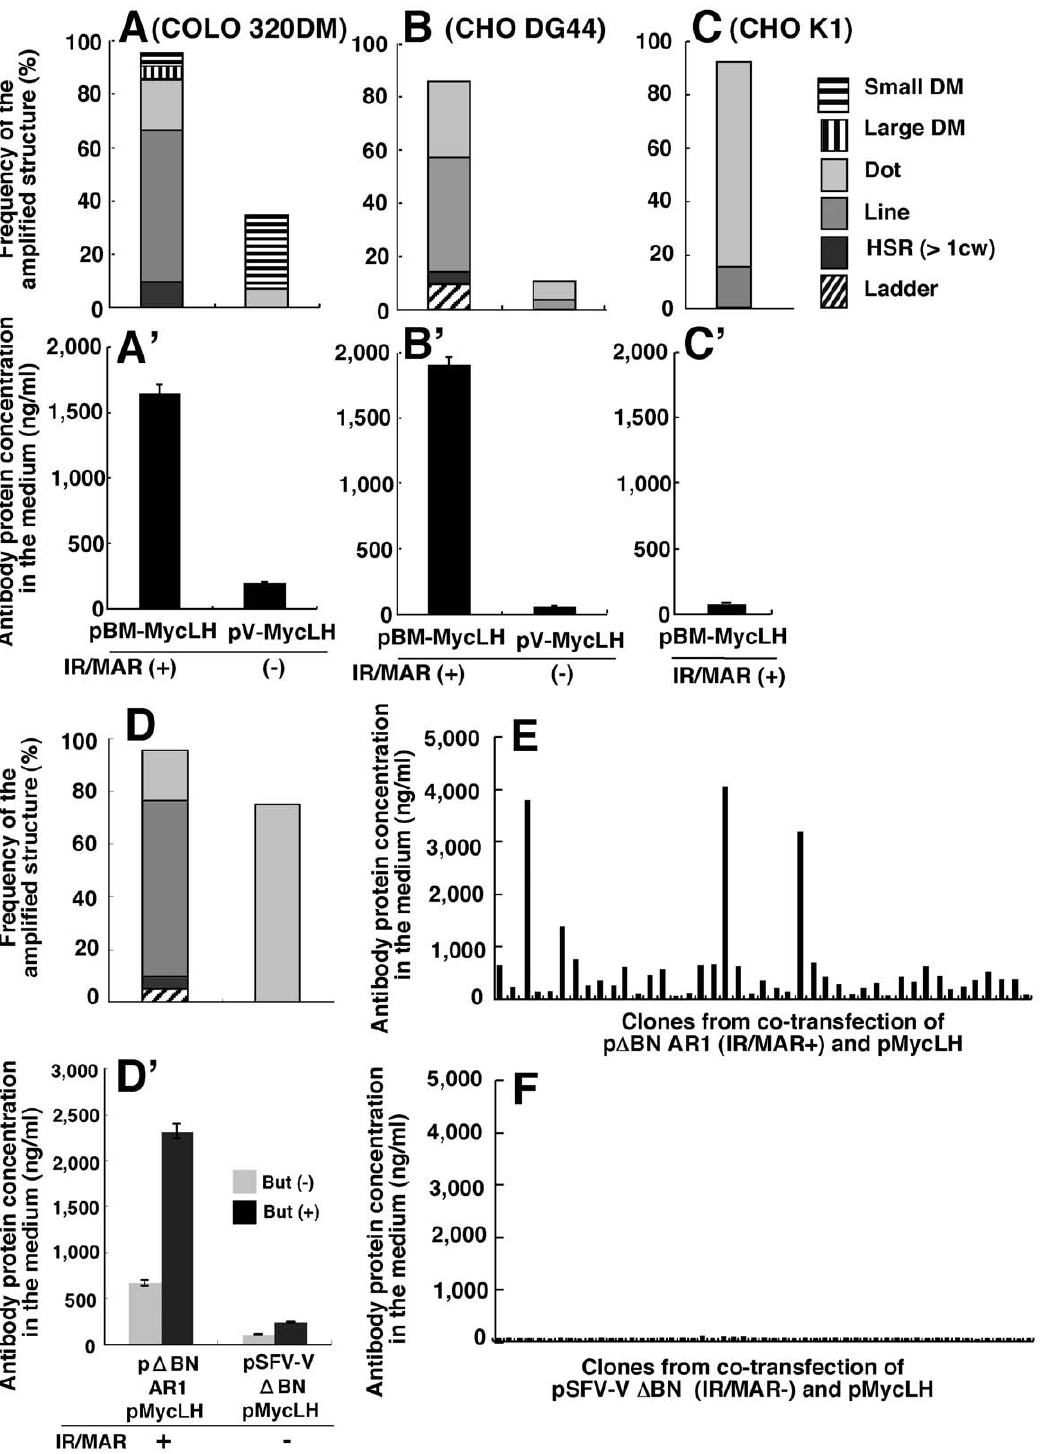
Figure 3. Efficient antibody production by the IR/MAR gene amplification method. COLO 320DM cells (A), CHO DG44 cells (B) and CHO- K1 cells (C) were transfected with IR/MAR-bearing pBM-MycLH or the control IR/MAR-negative pV-MycLH plasmid. CHO DG44 cells were co- transfected with IR/MAR-bearing p D BN.AR1 and pMycLH plasmids (D, E), or co-transfected with control pSFV-V and pMycLH (D, F) plasmids. After selection of the stable transformant for about one month, gene amplification (A to C, D) and antibody expression (A’ to D’) were examined by FISH and ELISA, respectively. Clones were obtained from the cells shown in D by the limiting dilution in 96 well plates. The wells bearing a single colony were microscopically determined, and the culture liquid was analyzed by ELISA. The horizontal axis of panel E or F corresponds to 43 or 53 clones, respectively.